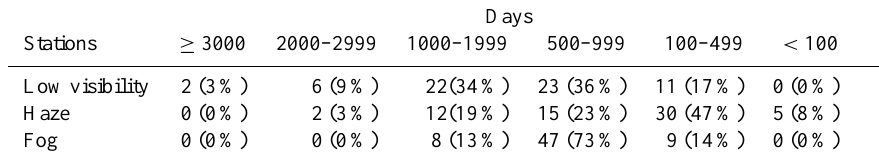
Table 1. The number (percentage) of stations under various count ranges of low visibility, haze and fog days during 1981–2010.